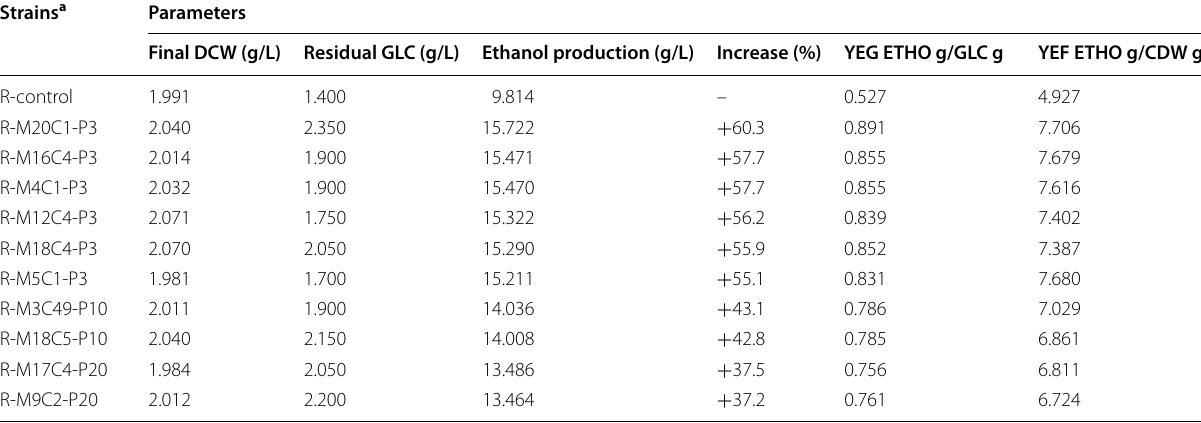
P3: 3% of MnCl 2 , P10: 10% of MnCl 2 and P20: 20% of MnCl 2 ; that were used in the Ep‑PCR reaction CDW dry cell weight, GLC glucose, YEG yield of ETHO g/glucose used g, YEF yield of ETHO g/final CDW g a Indicates to the highest mutant strains for ethanol production